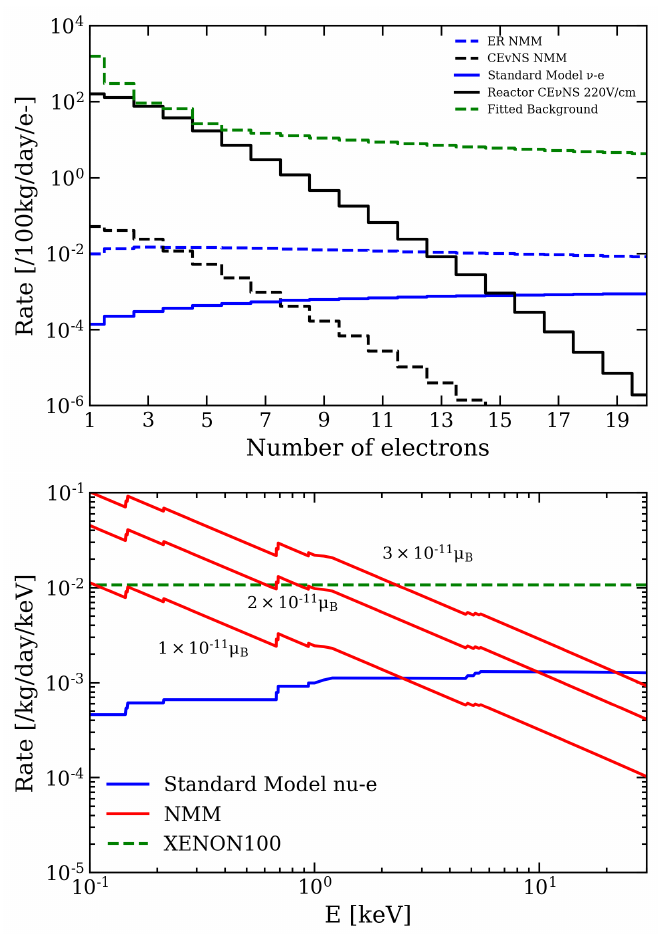
Figure 3. ( Top ): the SM (solid lines) and NMM contributions (black and blue dashed lines, assuming µ ν = 10 − 11 µ B ) to CE ν NS (black) and neutrino–electron scattering (green) channels for low-energy. events with “ionization (S2) only”. The “fitted background” (dashed green) from measured rates